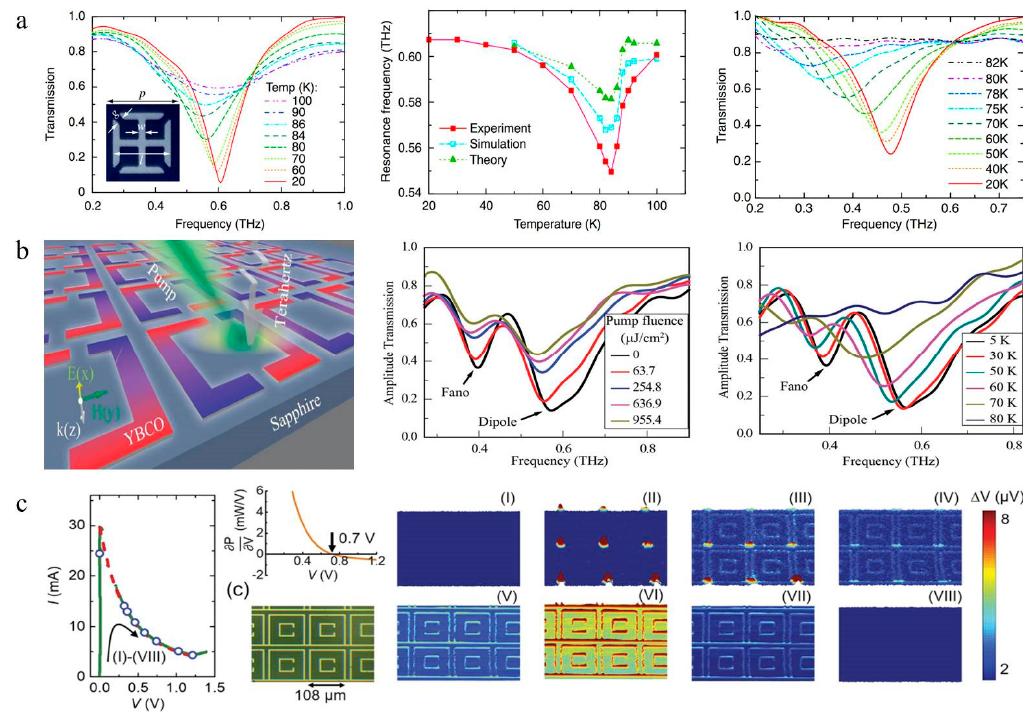
Figure 14. ( a ) Transmission amplitude spectrum at different temperatures, when the thickness of the yttrium-barium-copper oxide (YBCO) film is 180 and 50 nm [161], copyright American Physical Society, 2010. ( b ) An optical pump ultra-fast switch with YBCO based on a terahertz asymmetric Fano resonant ring [19], copyright John Wiley and Sons, 2018. ( c ) The measured I − V curve at 4.9 K and the low temperature scanning laser microscope (LTSLM) scan images at different DC bias voltages [164].